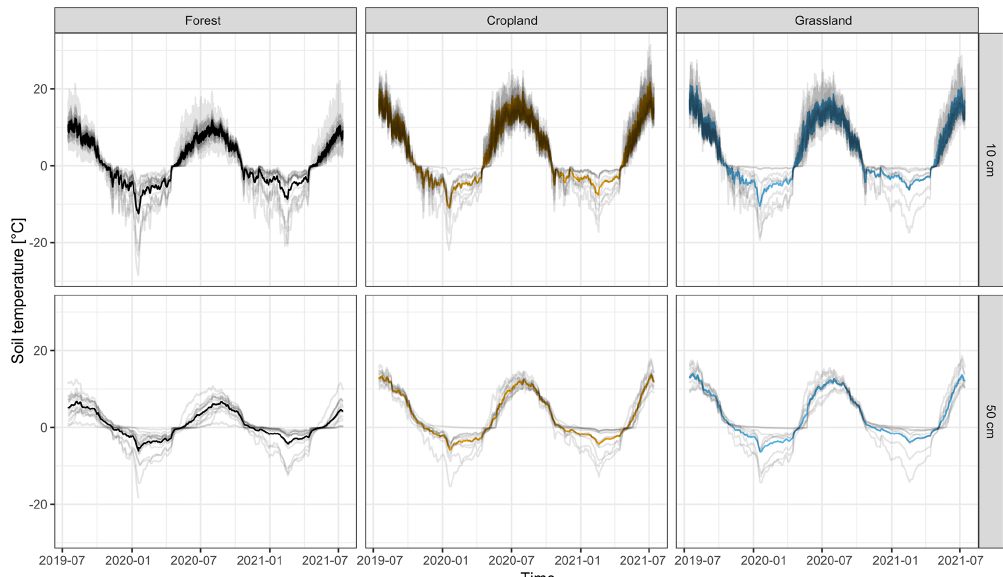
Figure 2. Soil temperature profile in forest, cropland and grassland at 10 and 50cm. Grey lines show the temperature of the individual sites; coloured lines indicate average temperatures. The date format is